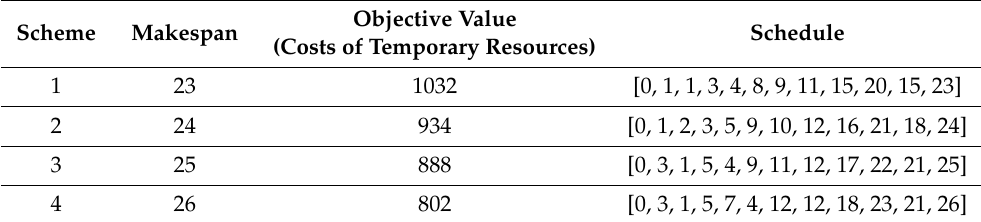
Figure 3. The schedule solution. Note: The red dots indicate the makespan and additional cost of 4 scheduling schemes respectively. Table 3. Optimization Schedules.